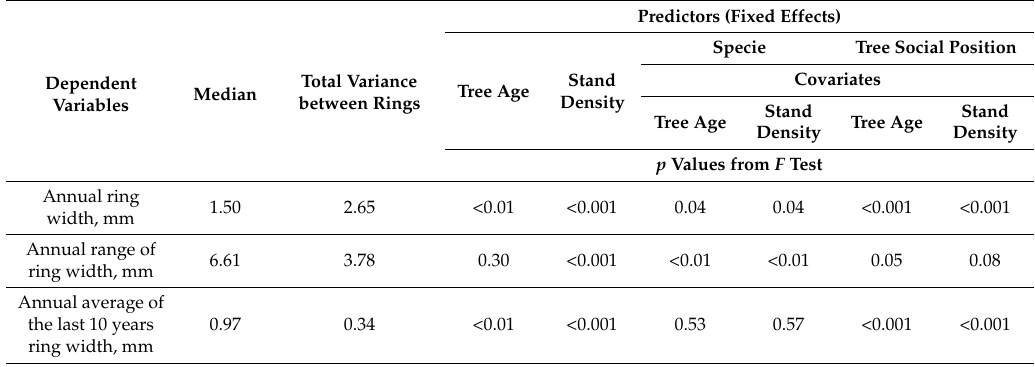
Table 2. Analysis of covariance (ANCOVA) of the growth structural traits.